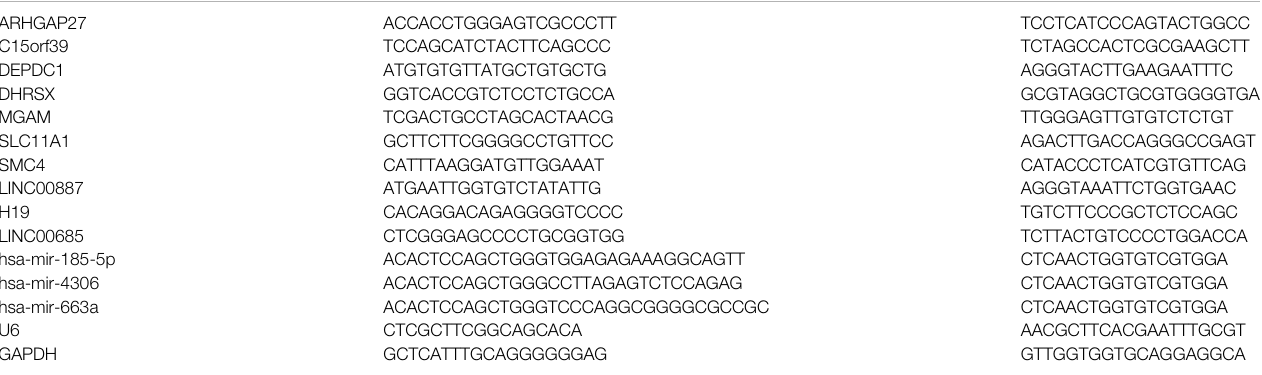
TABLE 2 | Sequence fragments of